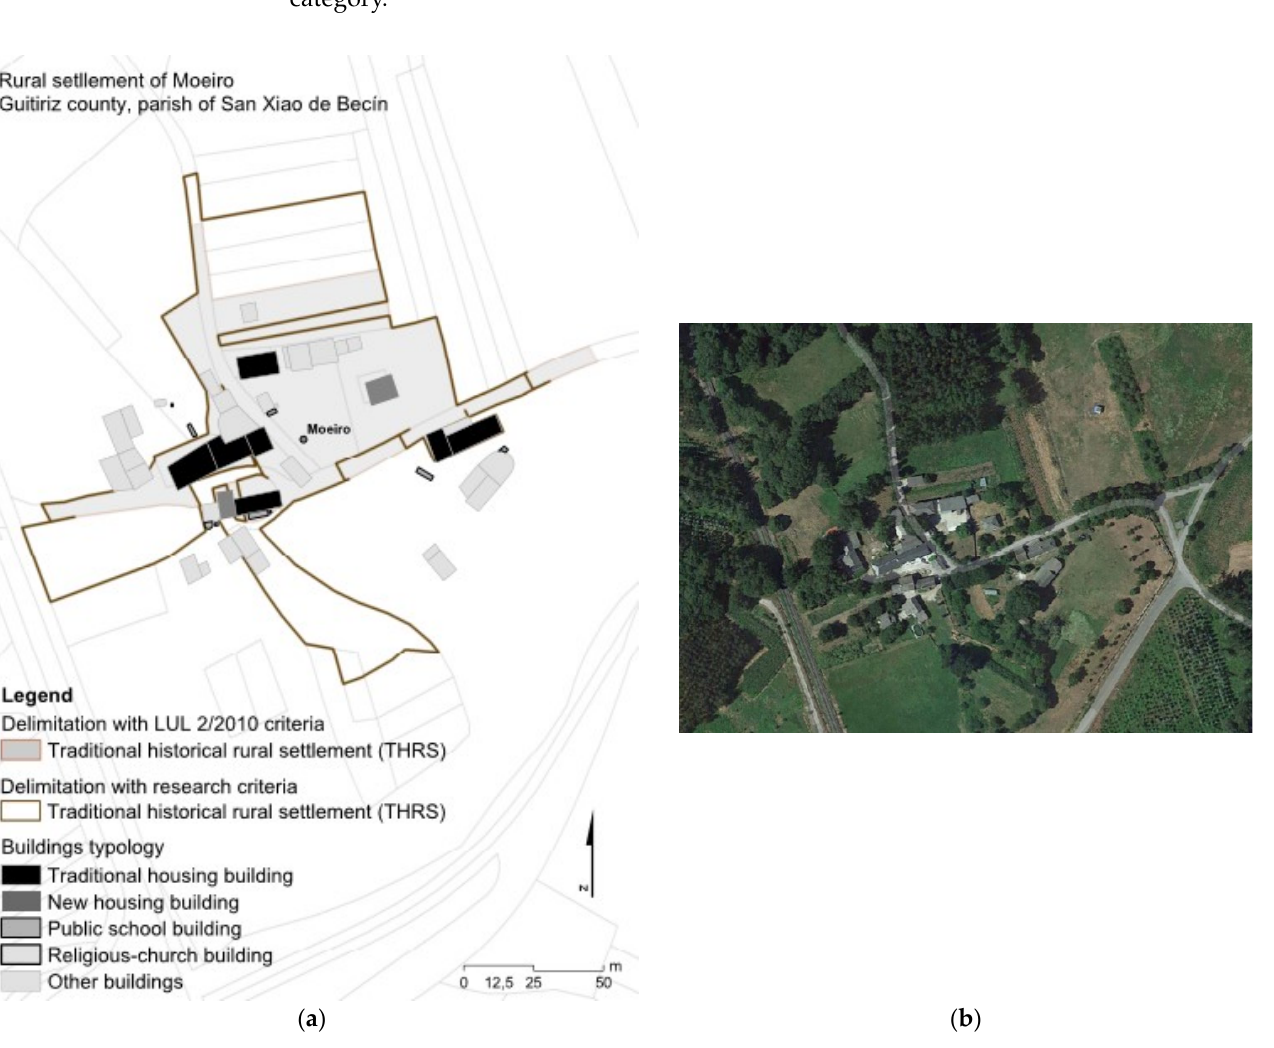
Figure 4. Delimitations according to LUL 2/2010 and the research criteria applied to RS of Moeiro ( a ). Aerial photo view of the RS on the right ( b ).